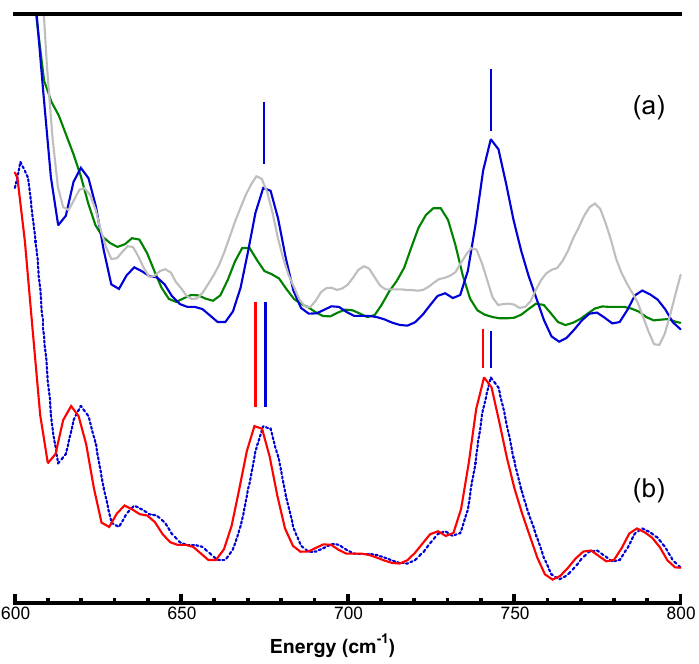
Figure 4. ( a ) NRVS PVDOS in the X–Fe–H region for Cr [FeFe] hydrogenase in the H hyd form calibrated with the traditional procedure (1): green = ODT, blue = wild type, grey = C169S; and ( b ) NRVS PVDOS for the sample spectrum of wild type enzyme re-calibrated with the time-scaled procedure (2) (red) vs. that calibrated with the traditional procedure (1) (dashed blue): the duplication of the wild type spectrum in 4a.